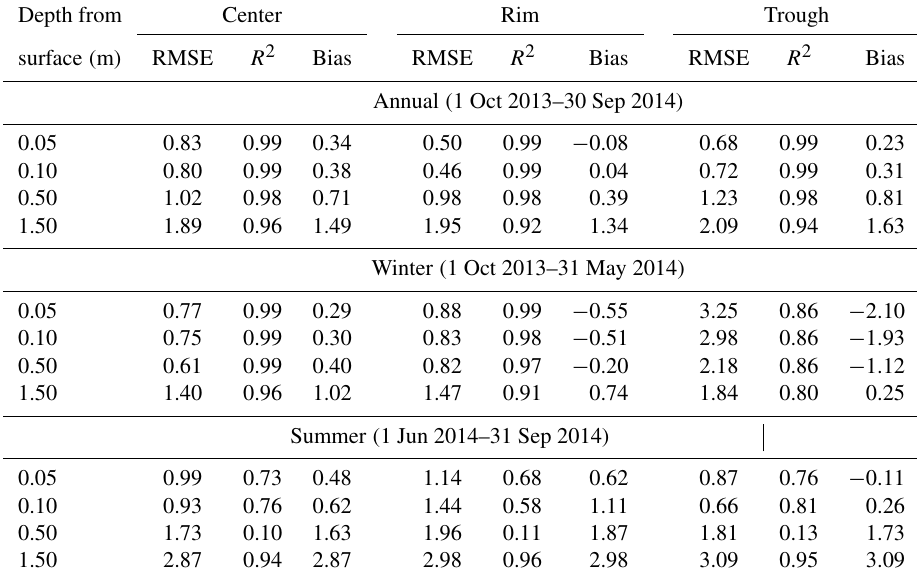
Table 4. Model performance statistics at Site B compared to observed soil temperatures (for annual, winter and summer periods). The model shows higher bias during the summer season compared to winter. Depth from